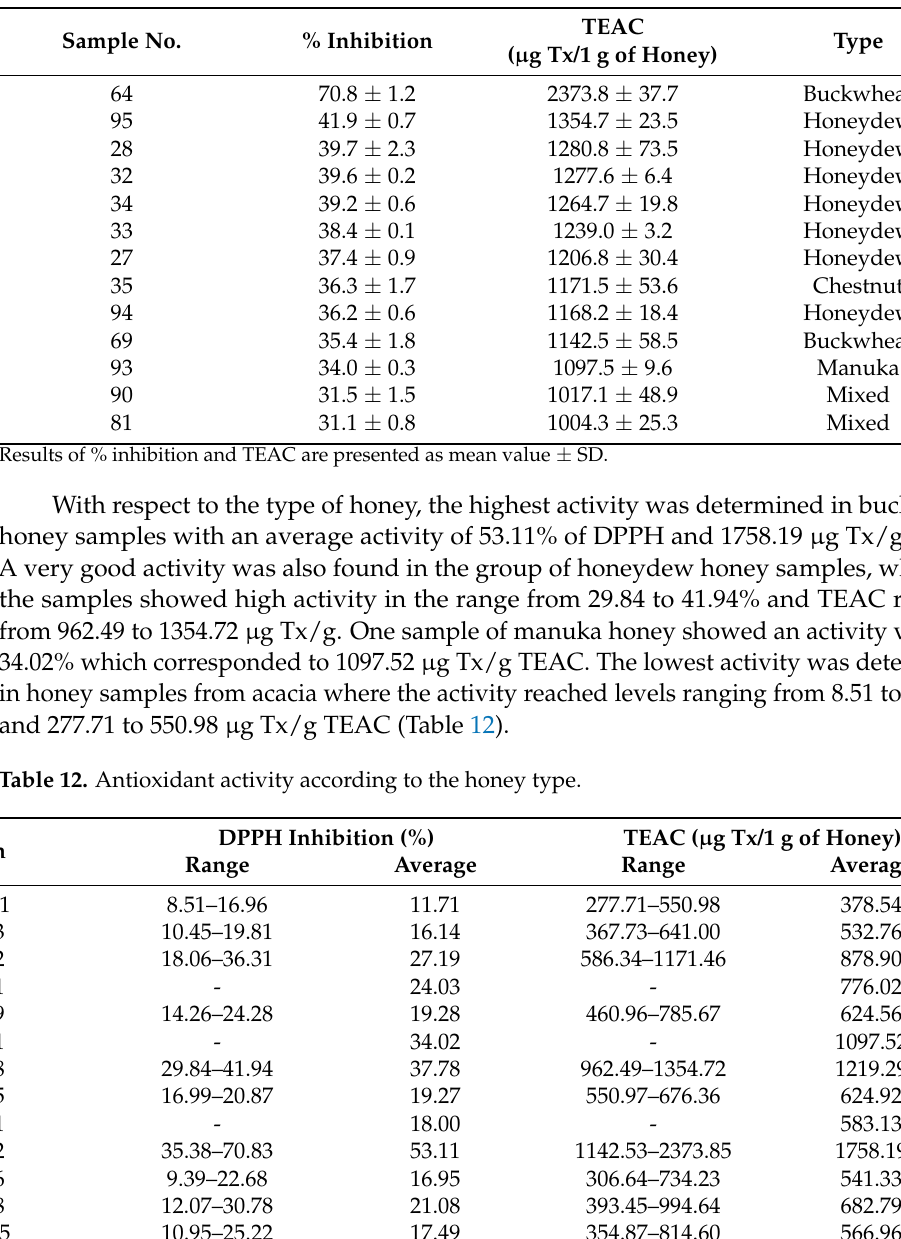
Table 11. Antioxidant activity of the honey (samples over 1000 TEAC).